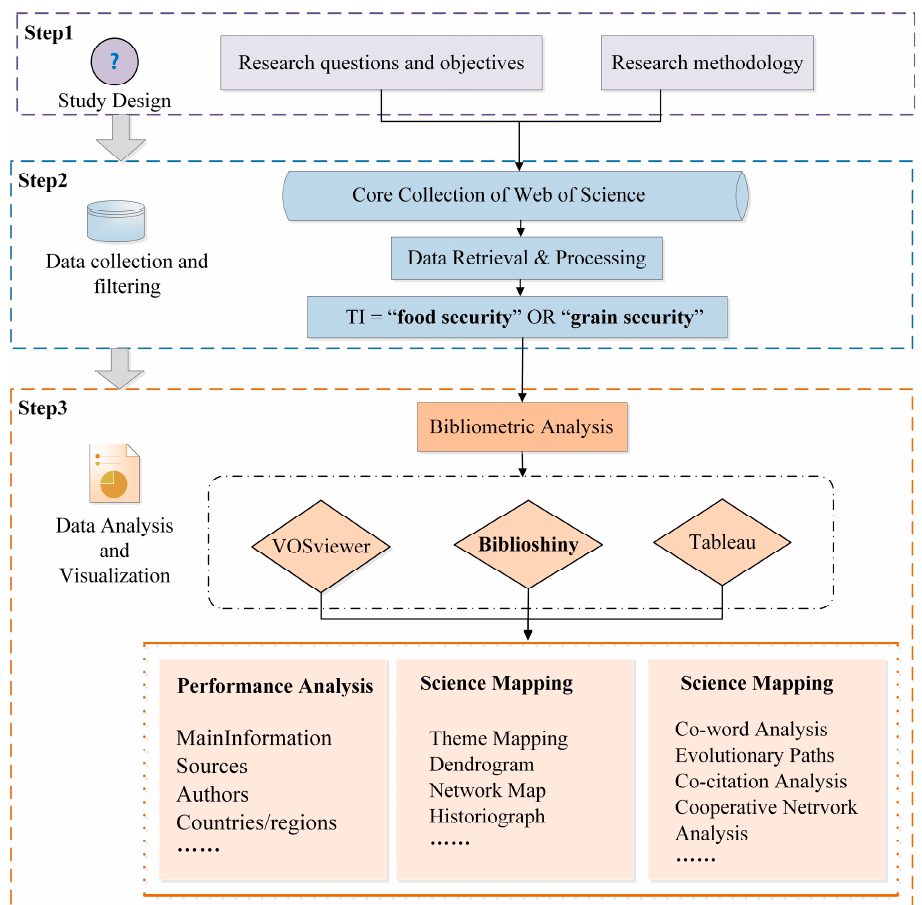
Figure 1. Measurement and analysis design process in the field of food security.